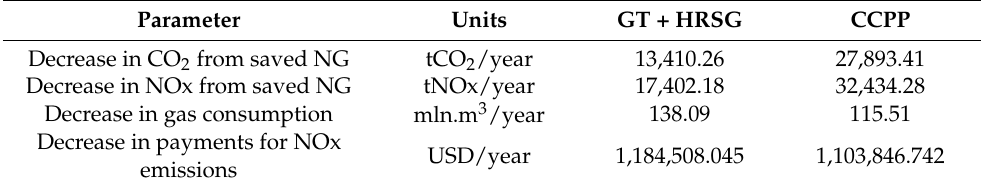
Table 6. Results of economic